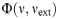
Activity flow in an illustrative network example.Left column: Global stability analysis in the single-population network. A Illustration of network architecture. C Upper panel: Input-output relationship Φ(ν,νext) for external Poisson drive νext=1601s shown in gray. In addition Φ(ν,νext) for τr=0 for the noiseless case (blue) and the noisy case (red). The inset shows the gray curve over a larger input range. Lower panel: Φ(ν,νext) for different rates of the external Poisson drive νext=[150,160,170]1s from black to light gray. Intersections with the identity line (dashed) mark fixed points of the system, which are shown in E as a function of νext. F Flux ν˙ in the bistable case for Φ(νext=1601s, K) in black, Φ(νext′=1611s, K) in blue, and modified system Φ(νext′=1611s, K′) in red. Intersections with zero (dashed line) mark fixed points. The inset shows an enlargement close to the LA fixed point. Horizontal bars at top of figure denote the size of the basin of attraction for each of the three settings. Right column: Global stability analysis in the network of two mutually coupled excitatory populations. B Illustration of network architecture. D Flow field and nullclines (dashed curves) for Φ(νext=1601s, K) and separatrices (solid lines), LA fixed point (rectangle), HA fixed point (cross) and unstable fixed points (circles) for Φ(νext=1601s, K) in black, Φ(νext=1611s, K) in blue, and Φ(νext=1611s, K′) in red. The red separatrix and the red unstable fixed point coincide with the black ones. G Enlargement of D close to the LA fixed points. Flow field of original system shown in black, of modified system in red.